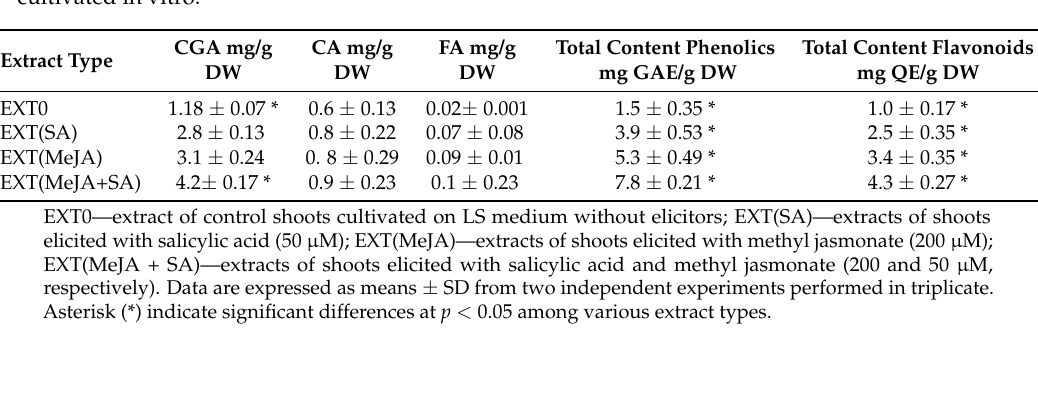
Figure 1. Antioxidant properties assessed using ABTS and DPPH methods for extracts obtained from shoots of P. filicifolia cultivated under various elicitor treatments: salicylic acid (SA, 50 µ M), methyl jasmonate (MeJA, 200 µ M), and (MeJA 200 µ M + SA 50 µ M): Data are expressed as means ± SD from two independent experiments performed in triplicate. All differences among various extract types in antioxidant activity are statistically significant at p < 0.05. Table 1. The content (mg/g DW) of phenolic acids: chlorogenic (CGA), caffeic (CA), ferulic acid (FA), total phenolics (GAE mg/g DW), and total flavonoids (QE mg/g DW) in elicited shoots of P. filcifolia cultivated in